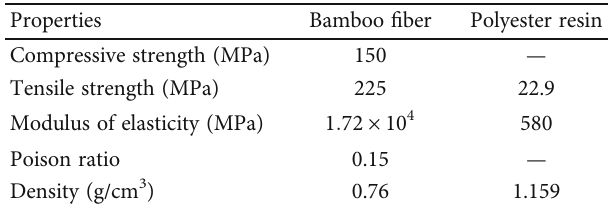
Table 1: Mechanical and physical properties of bamboo fi ber and polyester resin [30].